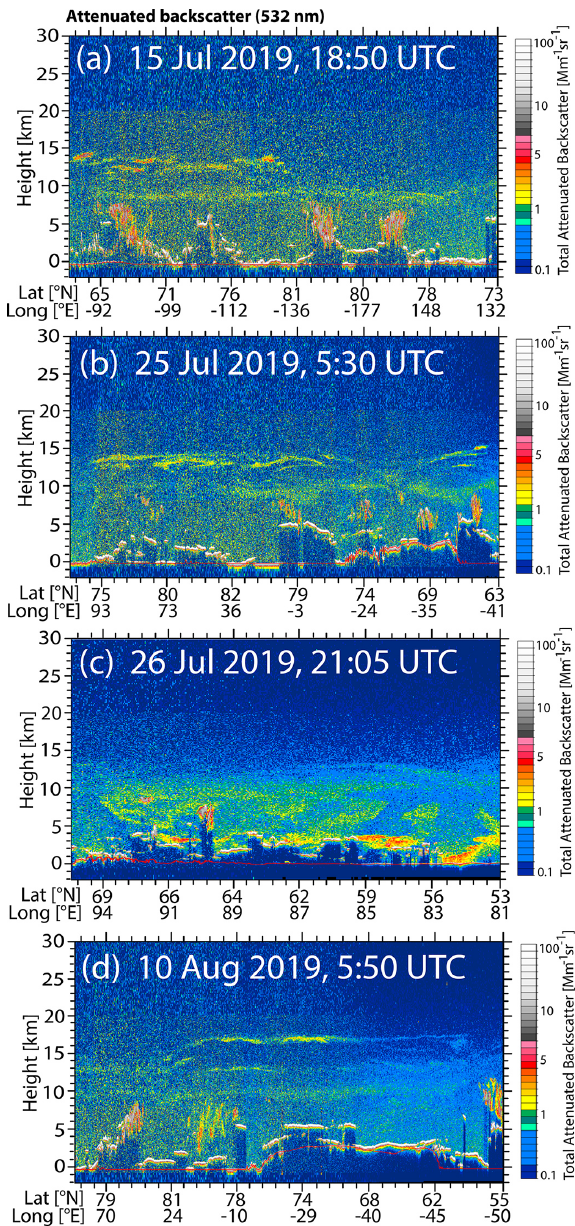
Figure 14. CALIOP measurement (height–latitude/longitude dis- play of 532nm attenuated aerosol backscatter) of wildfire smoke in the UTLS region over central Siberia and the Arctic on (a) 15 July 2019, (b) 25 July 2019, (c) 26 July 2019 (already dis- cussed in Ohneiser et al., 2021), and (d) 10 August 2019. Dif- fuse smoke layers (green, yellow), just below the tropopause at 9– 11km height were observed. Another backscatter maximum around 14km height is caused by pyroCb-related smoke and Raikoke sul- fate